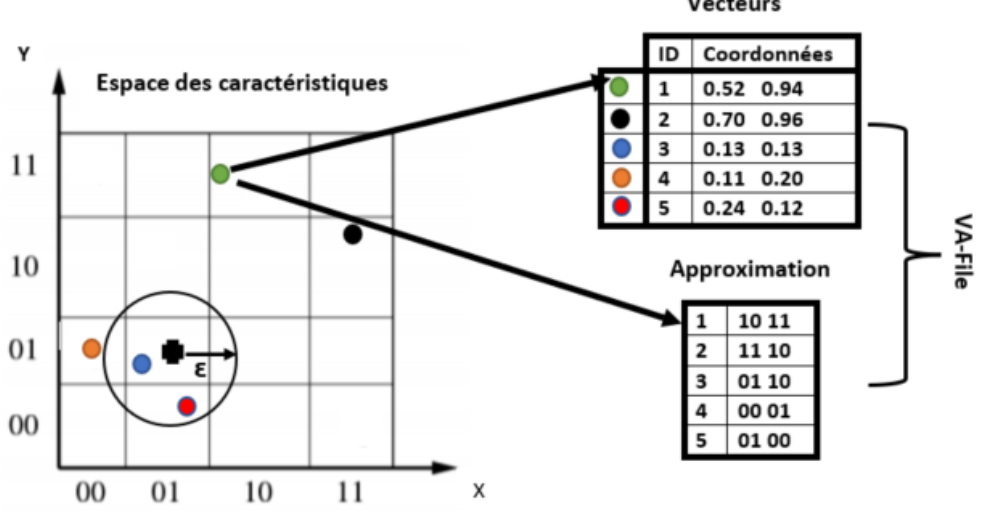
Figure 2. Geometric representation of